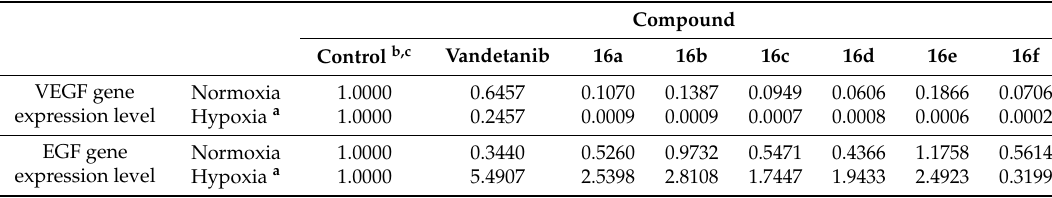
Table 3. VEGF/EGF gene expression level assay results of target compounds 16a – f